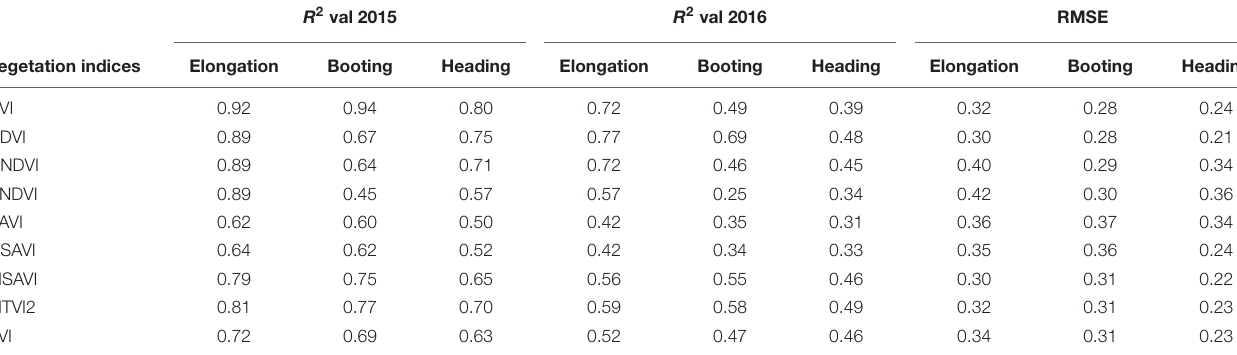
TABLE 5 | Validation of R 2 and RMSE for estimation of LAI at phenological